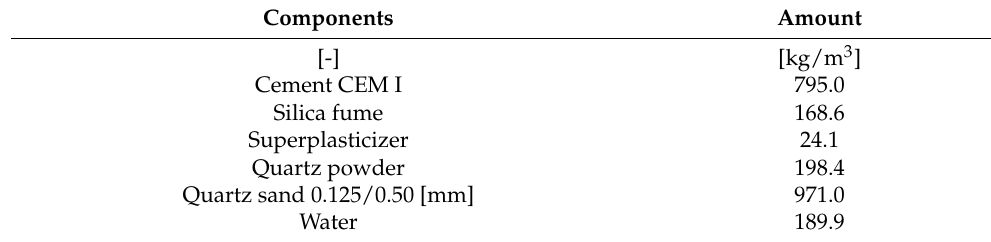
Table 1. Mix composition of